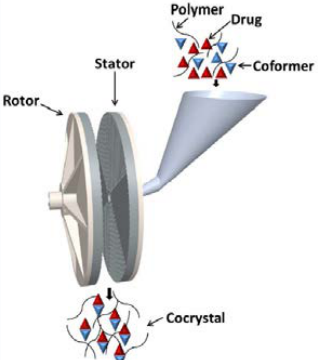
Figure 12. Schematic representation of ‘Solid-State Shear Milling’ technology for cocrystals production as proposed by Korde et al. [188] [Reprinted from [188] with permission. Copyright 2018 American Chemical Society].